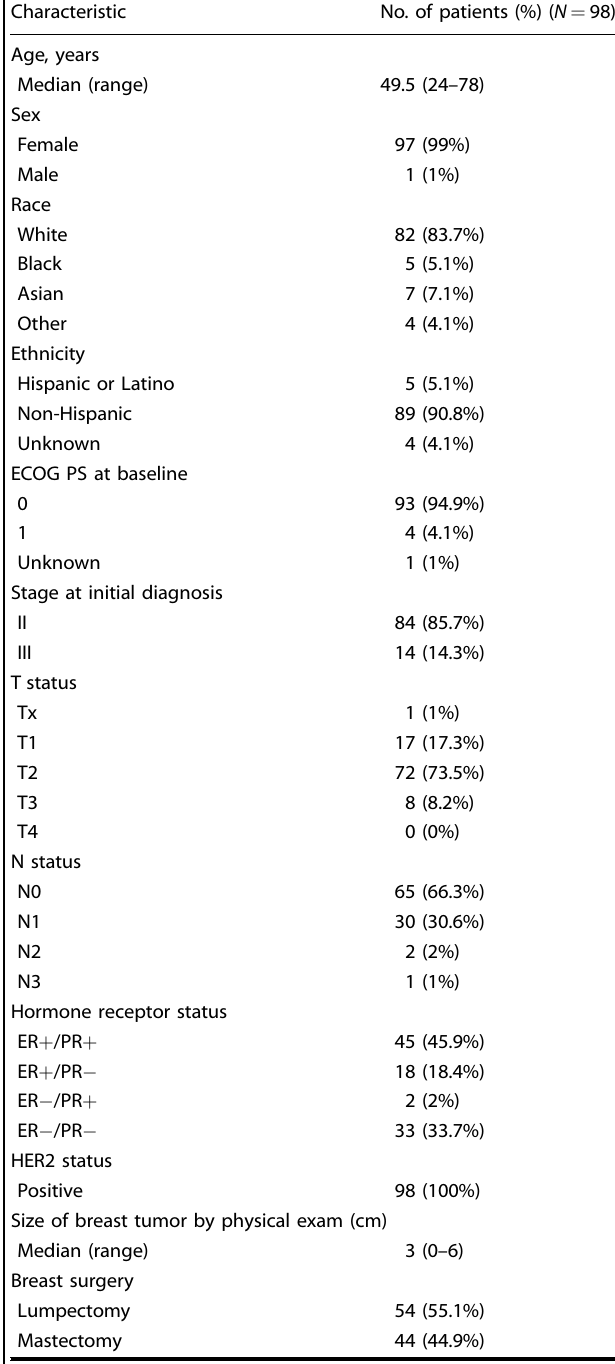
Table 1. Patient and tumor characteristics.